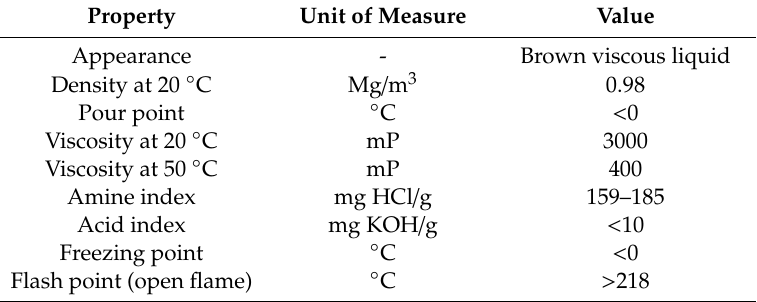
Table 2. Characteristics of the surface active agent surface active agent